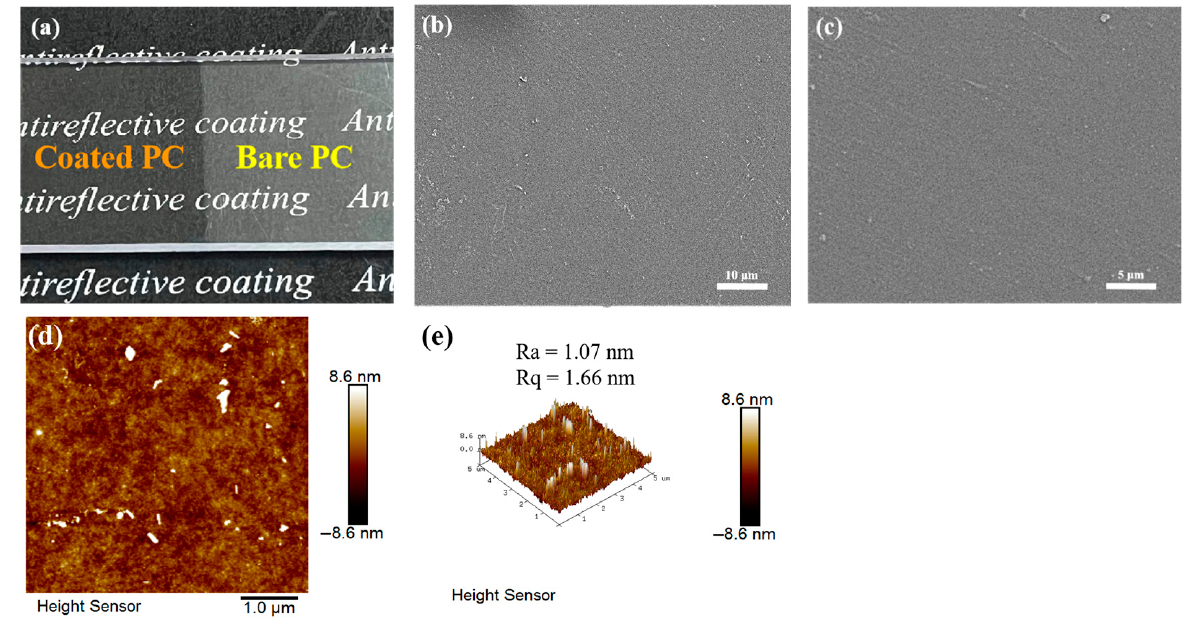
Figure 2. ( a ) Photos of the bare and coated PC, ( b , c ) SEM images, and ( d , e ) AFM surface topography and 3D images of the PFTS-modi fi ed 0.5 g ZrO 2 -SiO 2 sample.